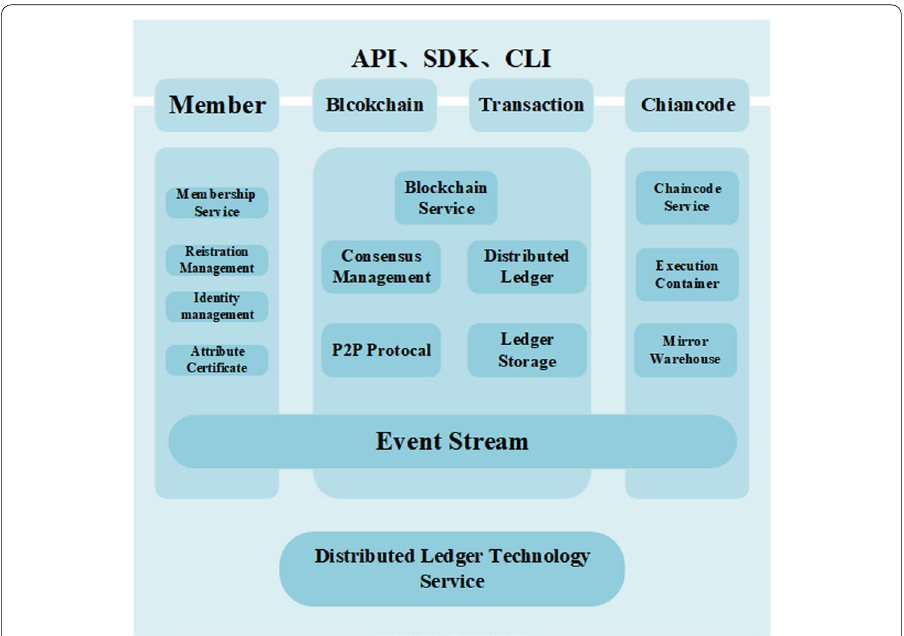
Fig. 2 The module architecture diagram of hyperledger